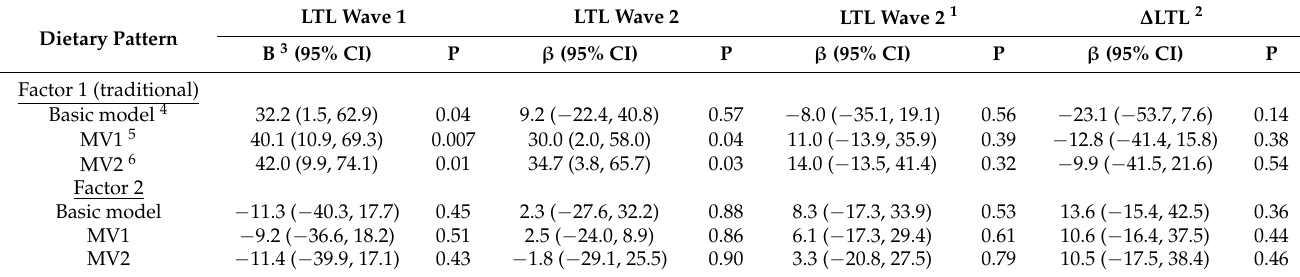
Table 3. Association of continuous baseline dietary patterns and telomere length (base-pairs) waves 1 and 2 of interviews. Dietary Pattern Factor 1